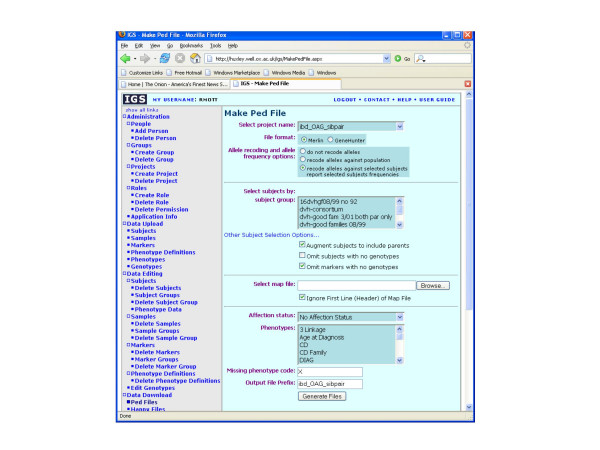
The IGS web interface to download Ped files. The user selects subjects and markers by choosing a subject group and a map file. Phenotypes are selected by name. Options controlling the output format are available as checkboxes. The left margin allows the user to navigate between the IGS web pages. Context-sensitive assistance is obtained by clicking on the top-right HELP button.